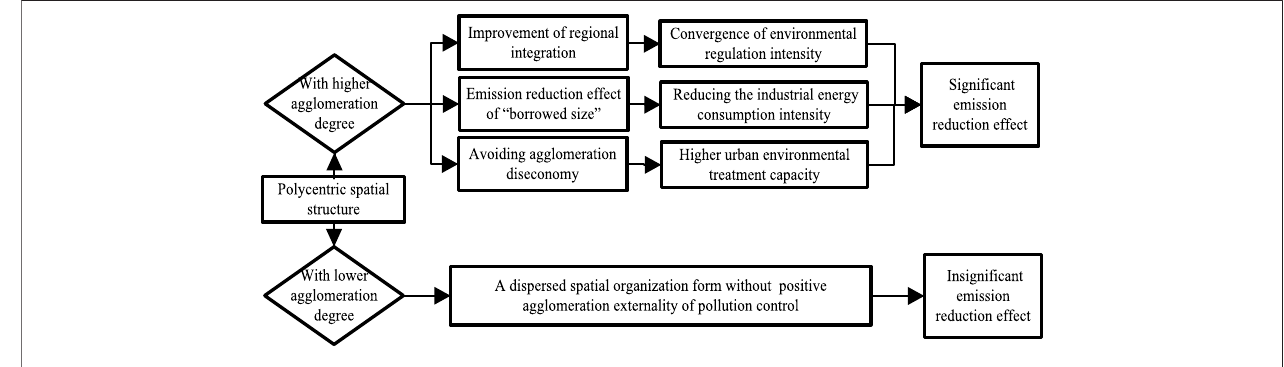
FIGURE 2 | Framework for polycentric spatial structure in fl uence on pollution